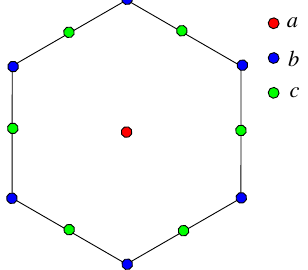
FIG. 11. Illustration of the Wyckoff positions a , b , and c for wallpaper group p 6 corresponding to the hexagon center, corner, and edge, respectively.